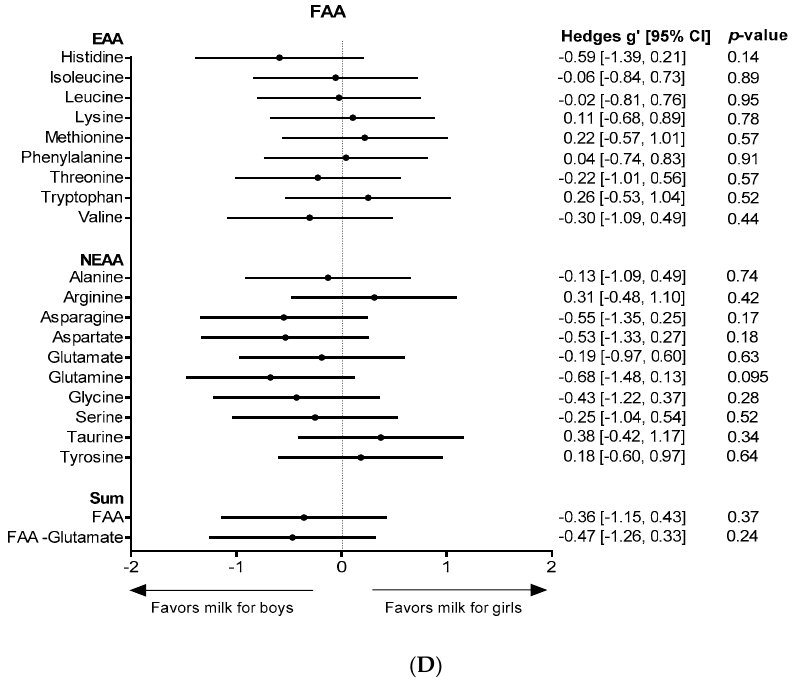
Figure 1. AA levels in milk for boys and milk for girls. Levels over the course of lactation are shown for ( A ) the sum of all TAAs, and ( B ) free glutamine. Forest plots indicating the effect sizes (Hedges’ g) of gender on the AA content in the first 3 months of lactation are shown for each individual TAA ( C ) and for each individual FAA ( D ). FAA: free amino acid; EAA: essential amino acid; NEAA: non-essential amino acid; Gln: glutamine, Asx: aspartate + asparagine; Glx: glutamate + glutamine.